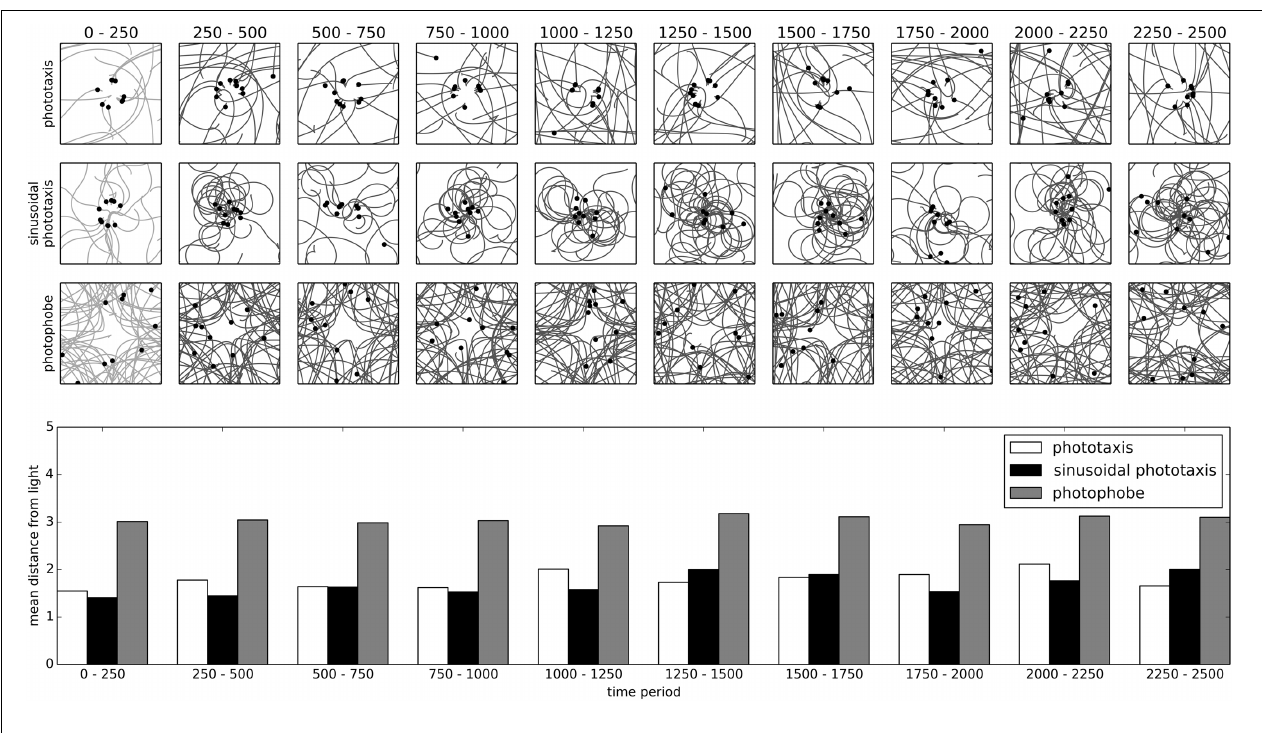
FIGURE 7 | Training of phototactic and photophobic behaviors and the long term evolution of each of the trained behaviors. The square frames show the spatial trajectories taken by a robot trained with the behavior indicated to the left of the row, during the time indicated at the top of the